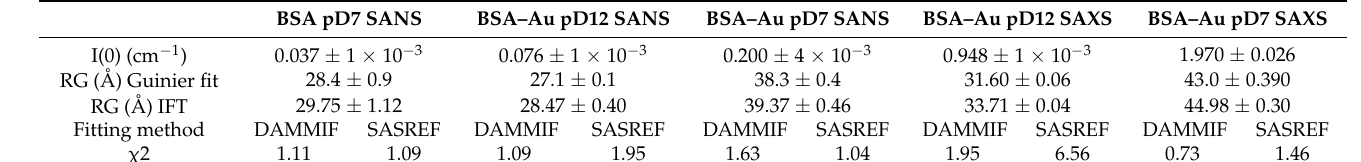
Table 3. Parameters obtained by the data evaluation of SANS and SAXS curves.